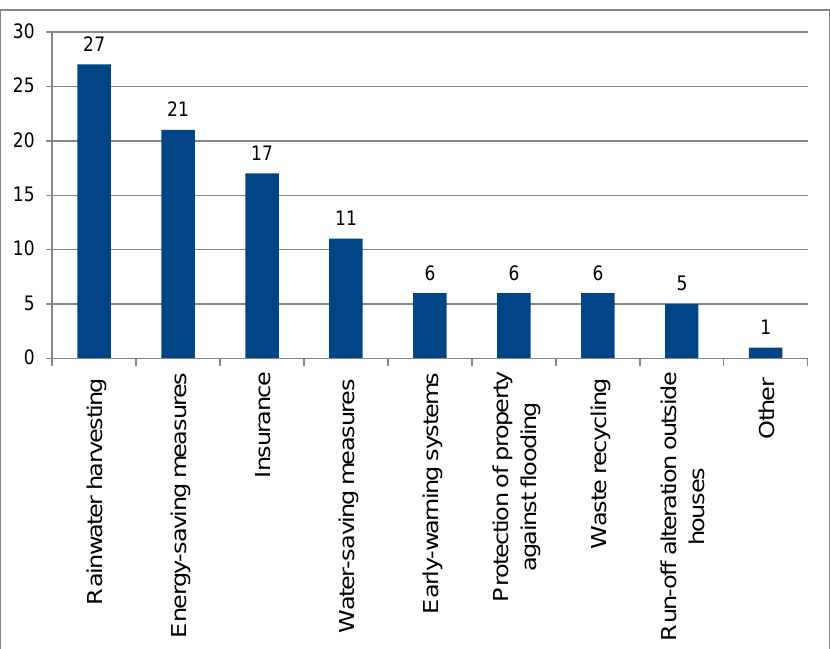
Table 5. Sociodemographic factors and engagement in adaptation and mitigation actions among the general population in the Czech Republic, N (%).